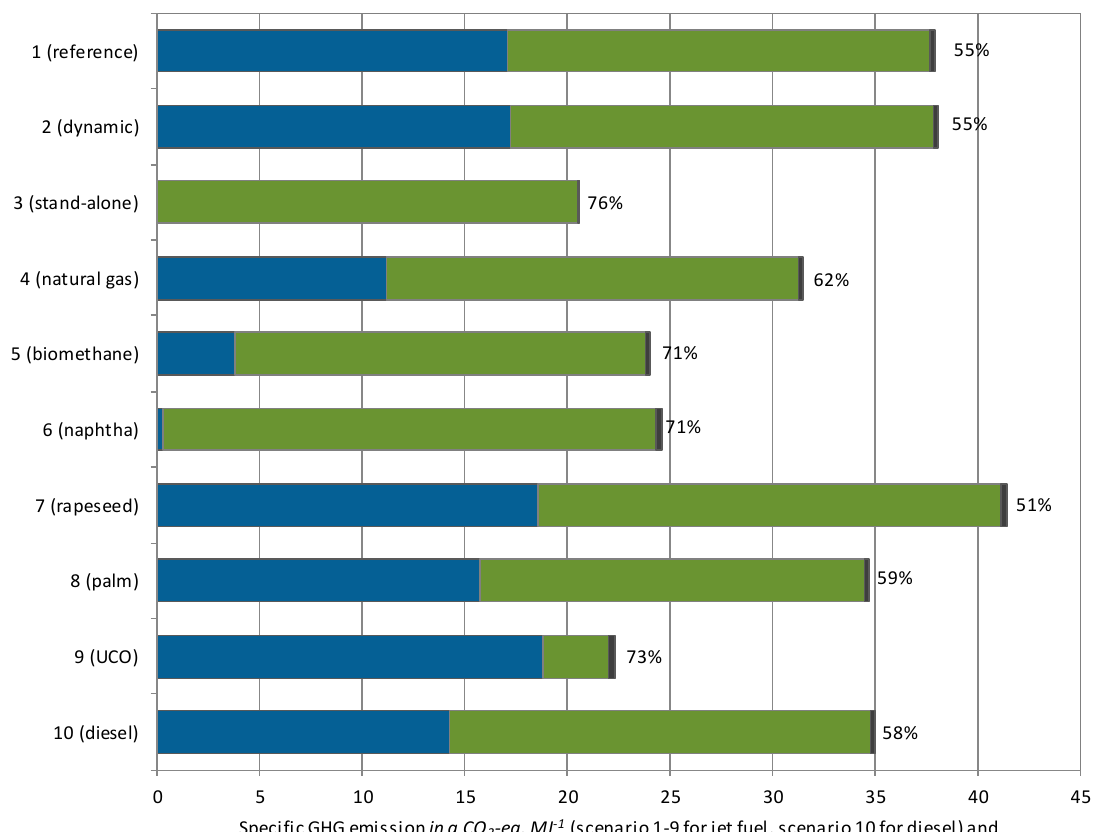
Figure 3. Specific GHG emission per scenario for HEFA-SPK and HEFA-diesel, and GHG mitigation potential compared to fossil reference of the European Renewable Energy Directive (RED).